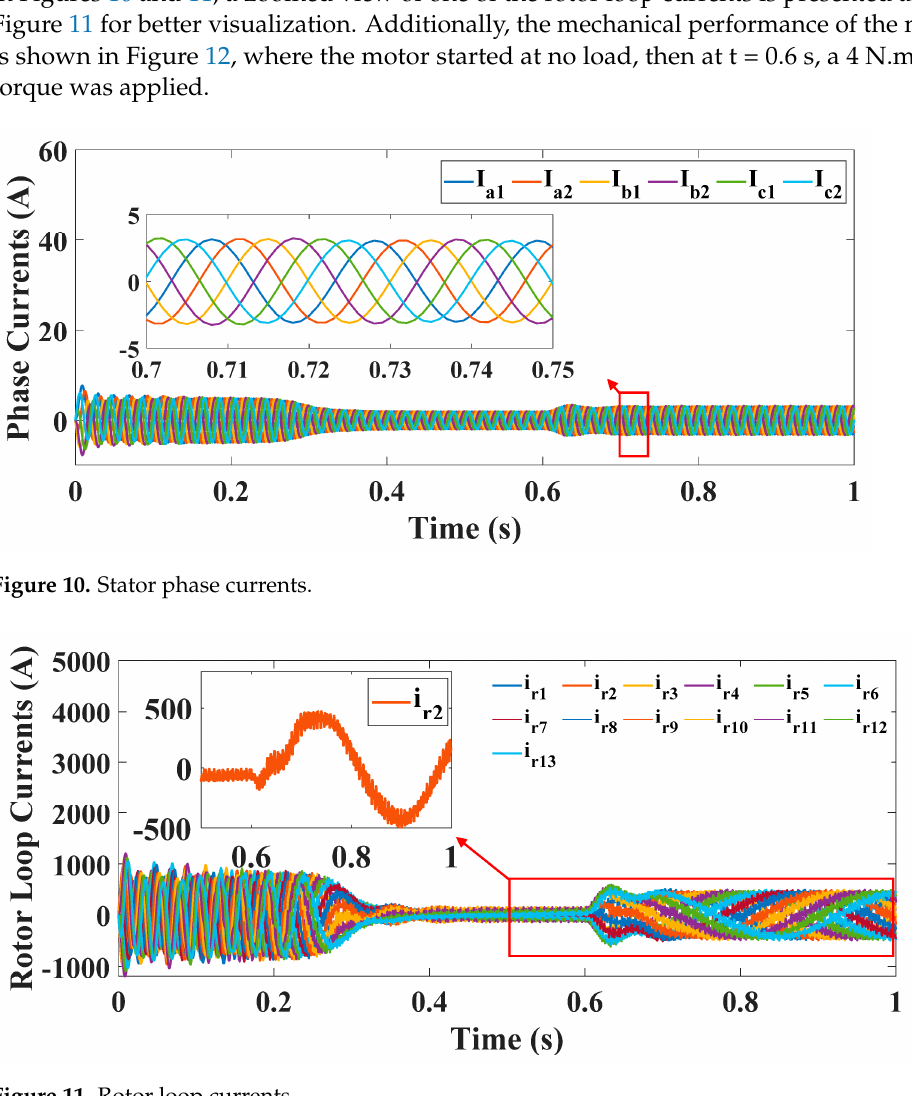
Figure 9. Bad connection test: ( a ) Phase current (a1); ( b ) Fault indices; ( c ) Ra1 (zoom-in view).